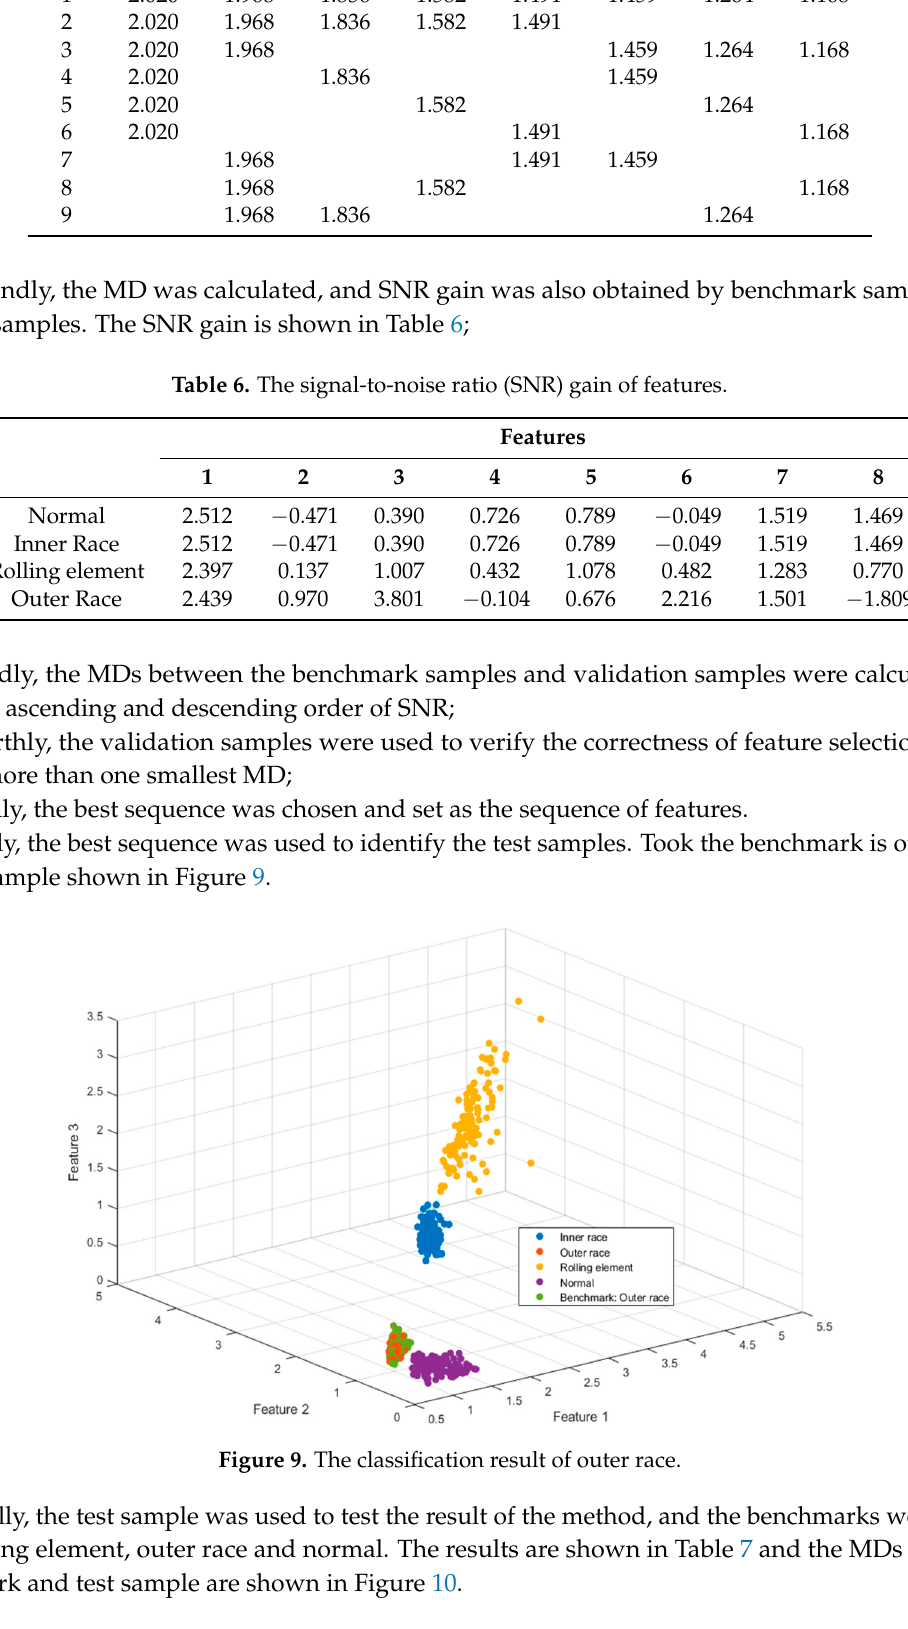
Table 5. The Mahalanobis space (MS) based on the inner race.